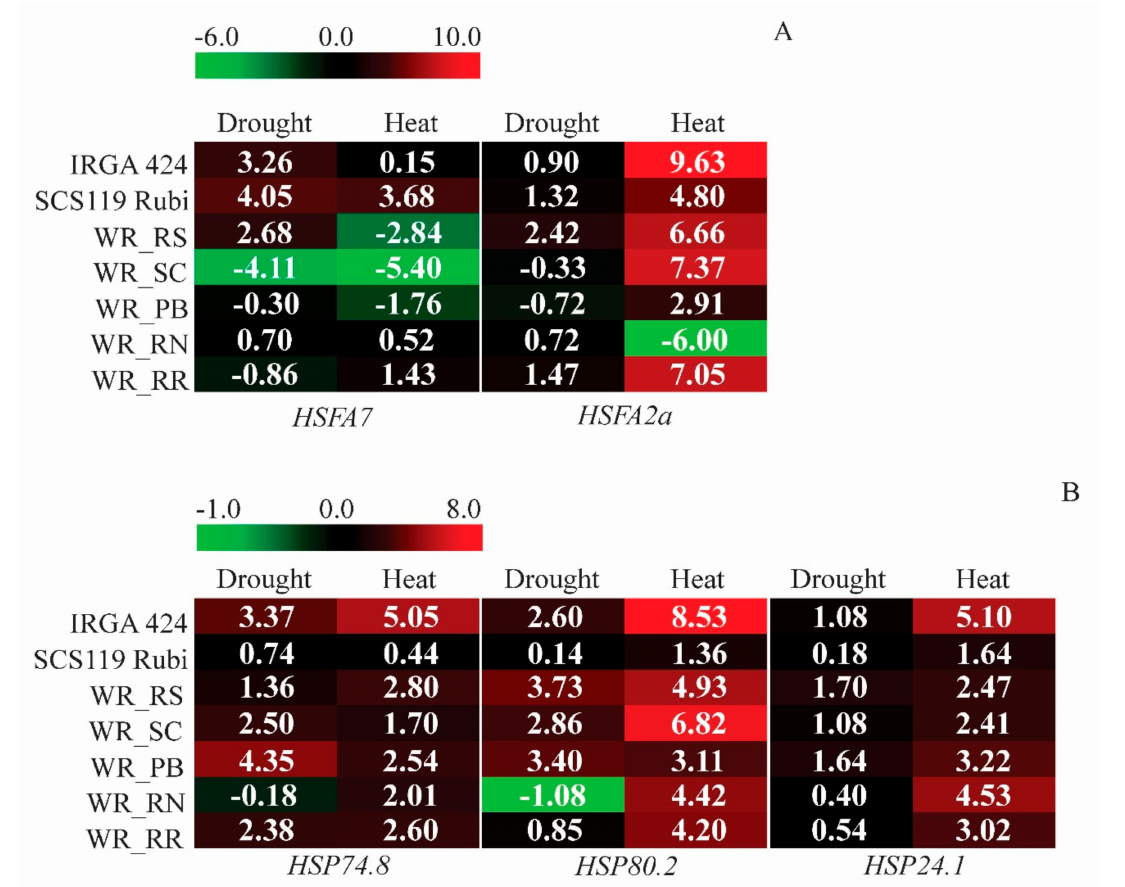
Figure 5. Relative mRNA abundance in rice and weedy rice leaves. Relative expression of HSF genes ( A ); Relative expression of HSP genes ( B ). mRNA abundance is represented in Log 2 fold-change using the Multi Experiment Viewer (TIGR MeV) software [64]. The color scale above the heat map shows the expression level; red = high transcript abundance, green = low transcript